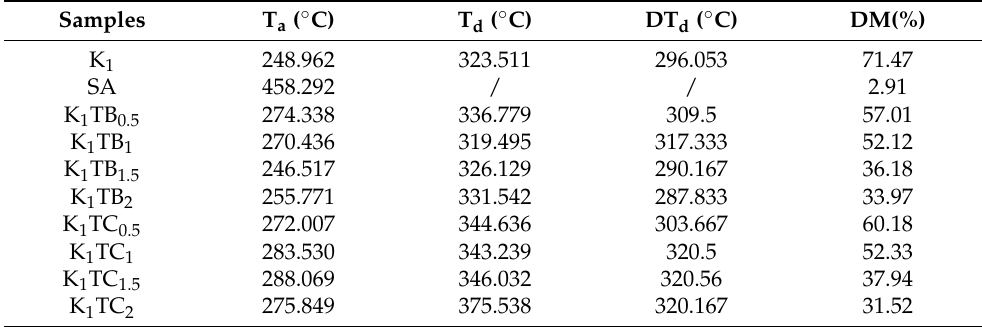
Table 2. The initial decomposition temperature T a ( ◦ C), maximum decomposition temperature T d ( ◦ C), maximum decomposition temperature by DTG DT d ( ◦ C), and degradation mass DM (%) calculated from the TG and DTG